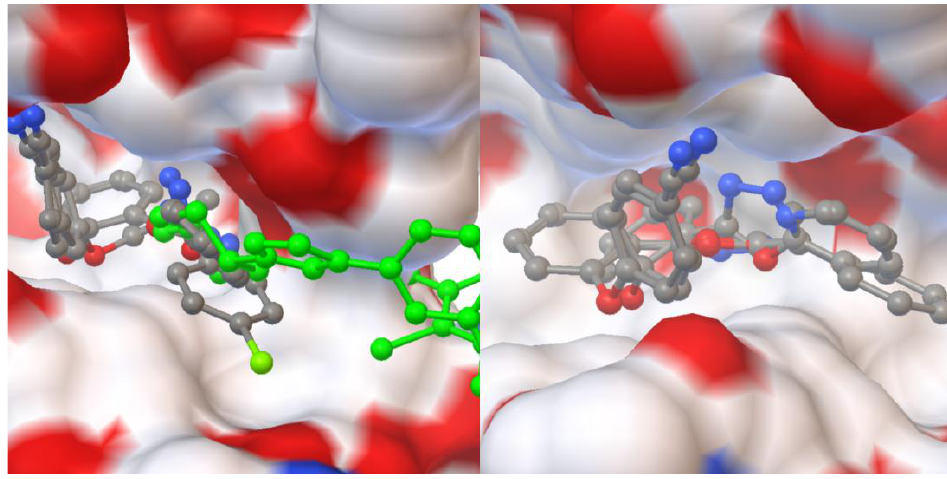
Figure 9. Superimposing poses of best scored compounds with and without reference drug crizotinib against lung cancer.